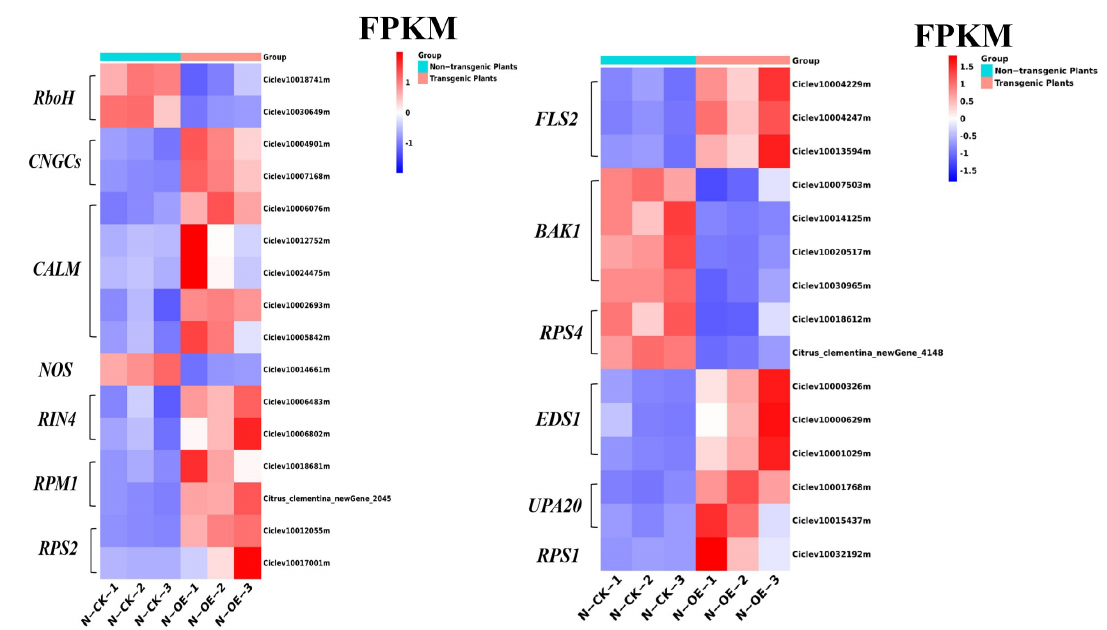
Figure 8. The FPKM of the DEGs in the plant–pathogen interaction pathway in the non-transgenic plants versus the transgenic